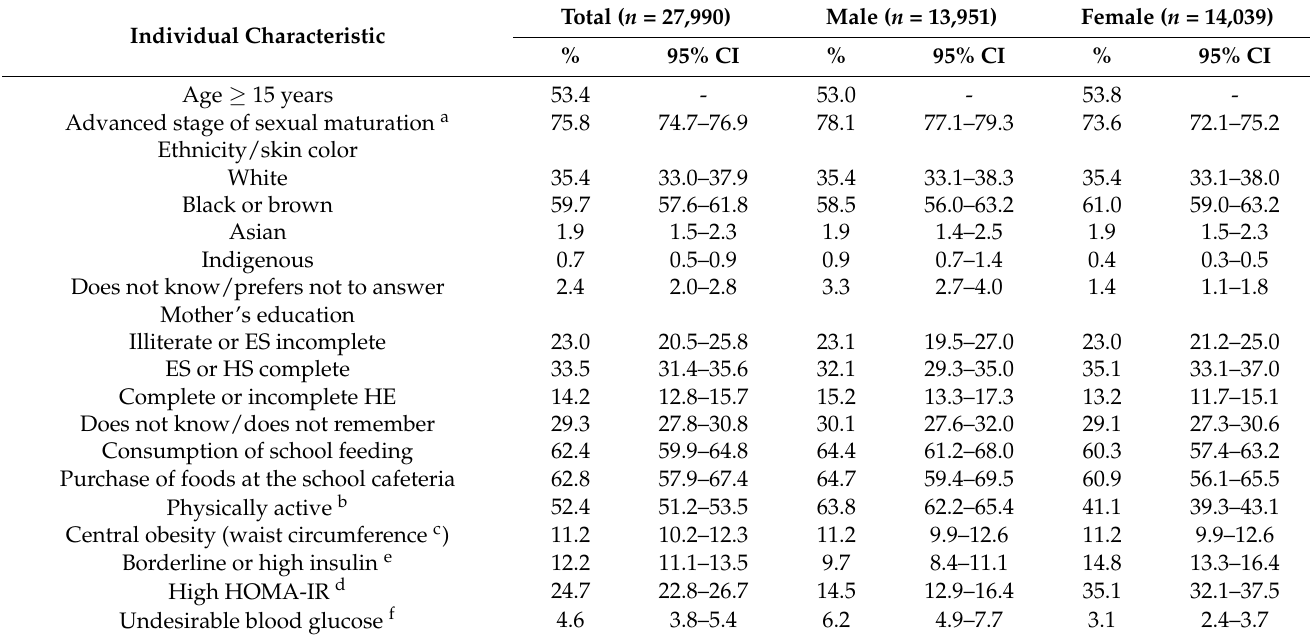
Table 2. Adolescents’ general characteristics by sex. Study of Cardiovascular Risks in Adolescents (ERICA), Brazil, 2013–2014.